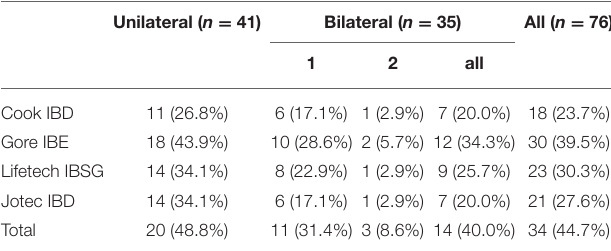
TABLE 5 | Exclusion for patients with unilateral and bilateral